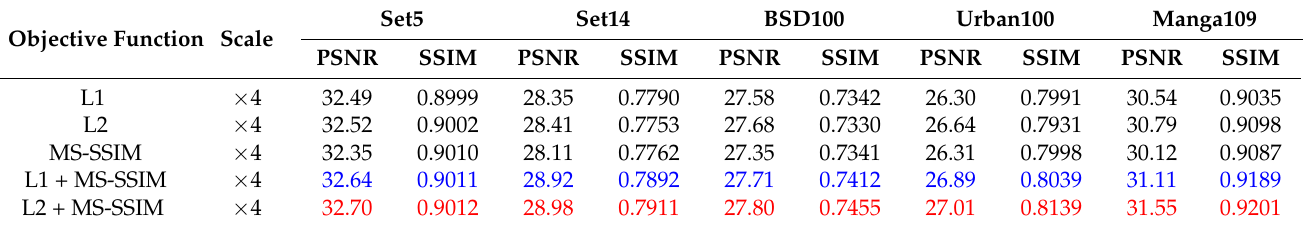
Table 3. Quantitative performance comparison among different objective functions at × 4